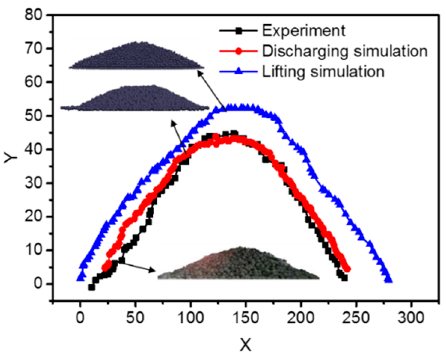
Figure 8. Profile of heap in simulation and experiment.